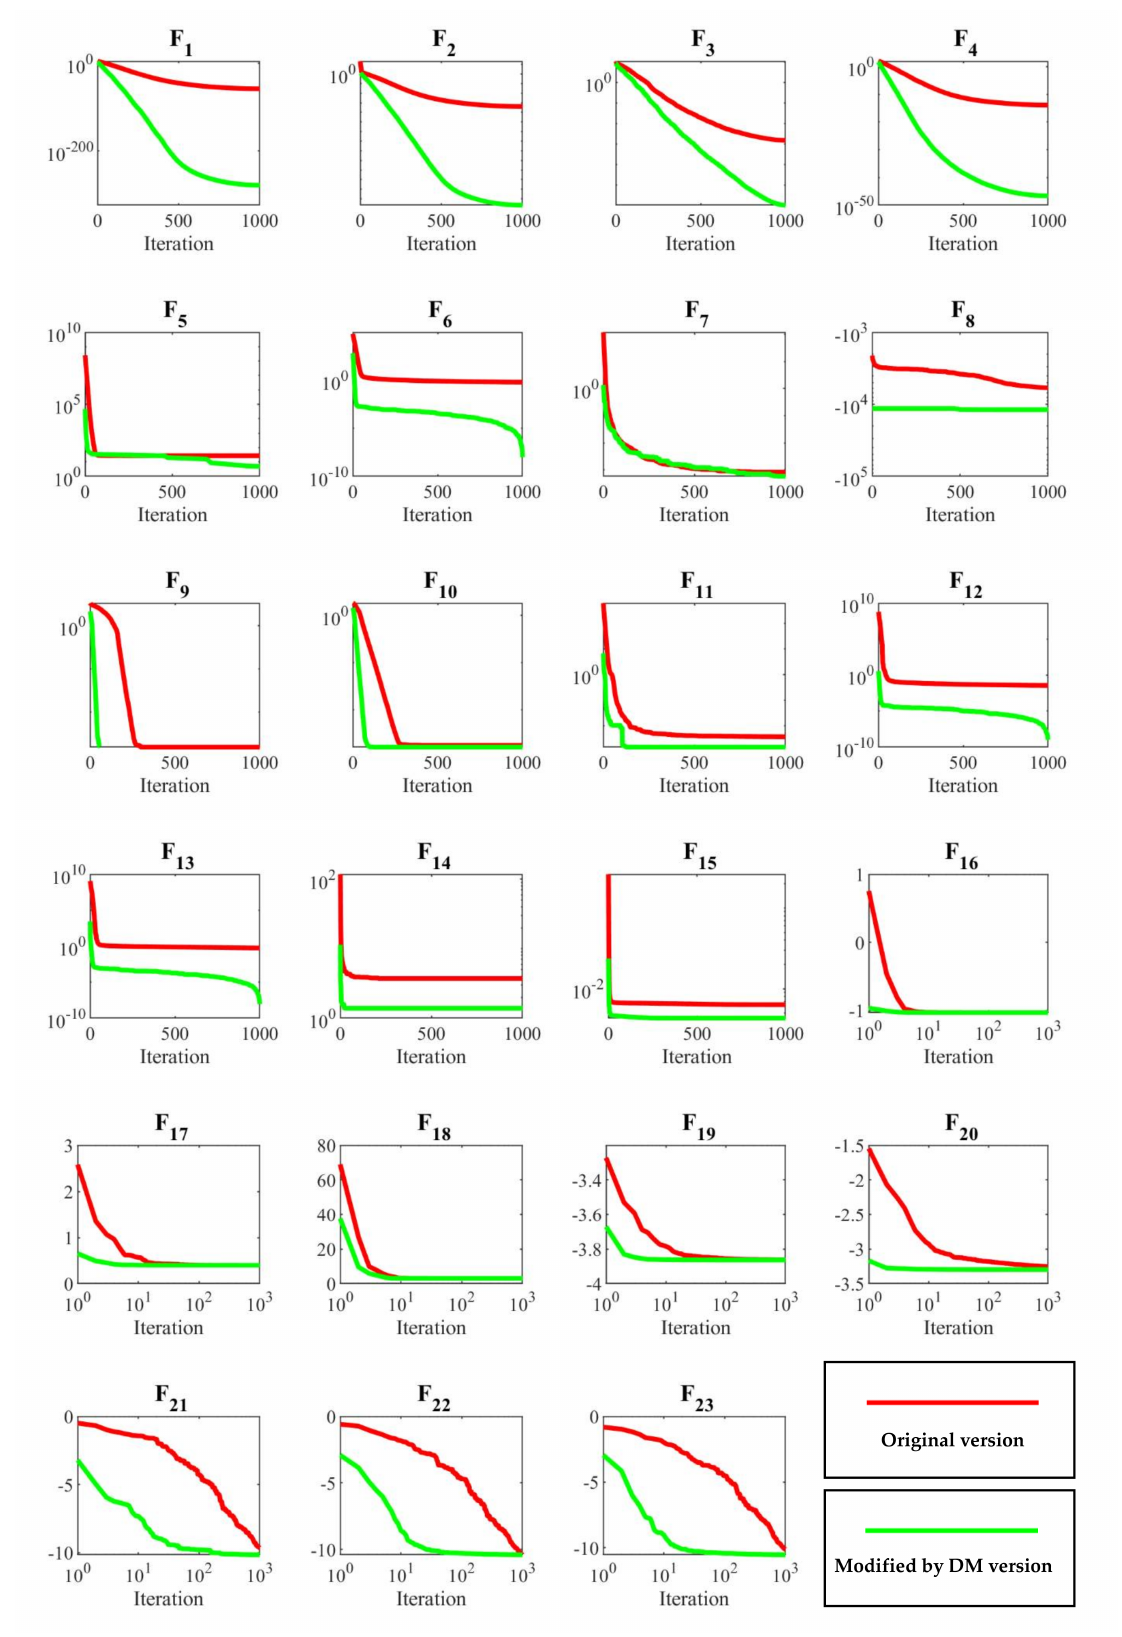
Figure 7. The convergence curves of GWO for original and “modified by DM”